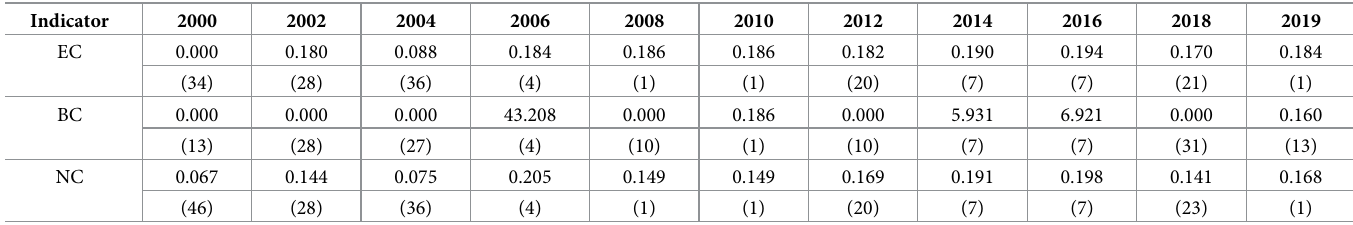
Table 5. Statistics on individual characteristics of China in